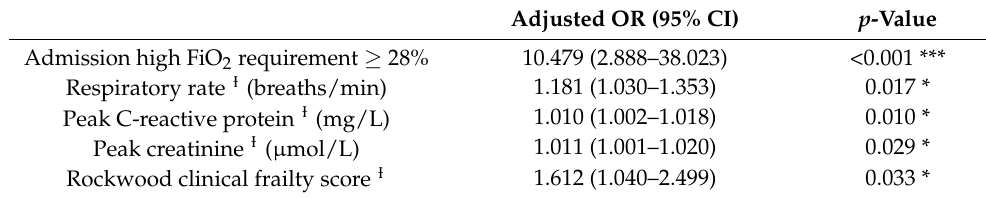
Table 3. Adjusted odds ratios of variables from adjusted multivariate logistical regression against Table 1. Results of univariate logistical regression of categorical variables against inpatient death. OR, Odds ratio; CI, Confidence interval. Ɨ , As opposed to care home residence or supported living. *, p < 0.05; ***, p < 0.001. Table 1. Results of univariate logistical regression of categorical variables against inpatient death. OR, Odds ratio; CI, inpatient death, in the 95 patients for whom data for all patients was available. OR, Odds ratio; Confidence interval. Ɨ , As opposed to care home residence or supported living. *, p < 0.05; ***, p < 0.001. Table 1. Results of univariate logistical regression of categorical variables against inpatient death. OR, Odds ratio; CI, CI, Confidence interval. Confidence interval. Ɨ , As opposed to care home residence or supported living. *, p < 0.05; ***, p < 0.001. Table 1. Results of univariate logistical regression of categorical variables against inpatient death. OR, Odds ratio; CI, Total (Died) Confidence interval. Ɨ , As opposed to care home residence or supported living. *, p < 0.05; ***, p < Total (Died)